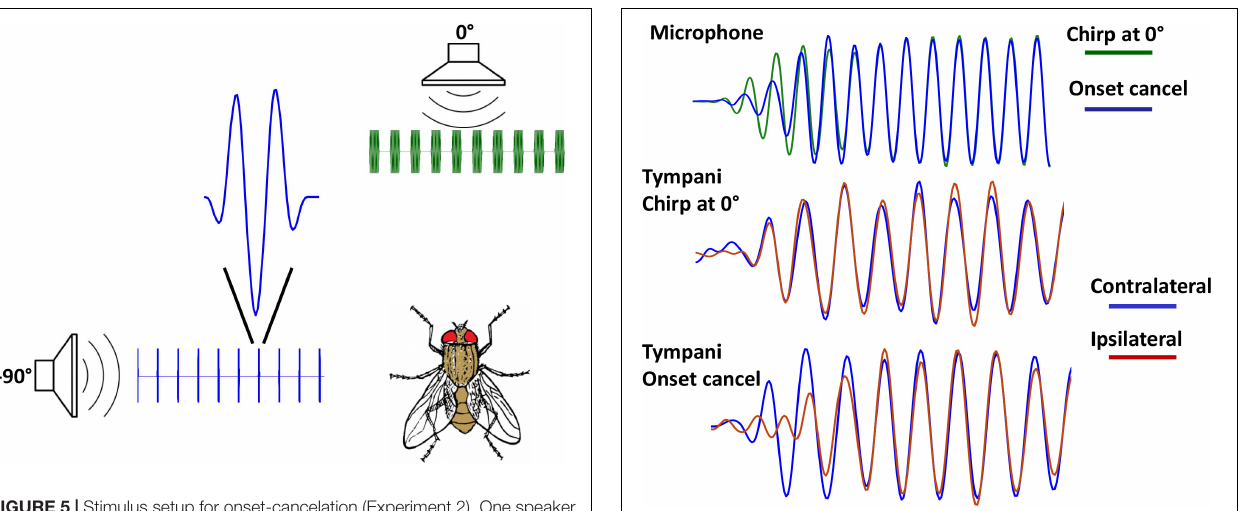
FIGURE 5 | Stimulus setup for onset-cancelation (Experiment 2). One speaker broadcasts an attractive stimulus at 0 ◦ (which should elicit phonotaxis in the forward direction). A second speaker, at 90 ◦ , broadcasts a series of impulses adjusted in amplitude and phase to cancel the initial portion of the attractive stimulus waveform. Due to the directional properties of the tympanal membranes, and the lateral location of the impulse source, cancelation will be greater for the tympanum ipsilateral to the impulse source (contralateral tympanal vibration for a 90 ◦ source will be attenuated relative to ipsilateral by 12 dB in these measurements). This condition should elicit equal-amplitude, in-phase tympanal vibration (consistent with a forward source location) but with a delay in the onset of the stimulus envelope on one side (ipsilateral to the impulse source).